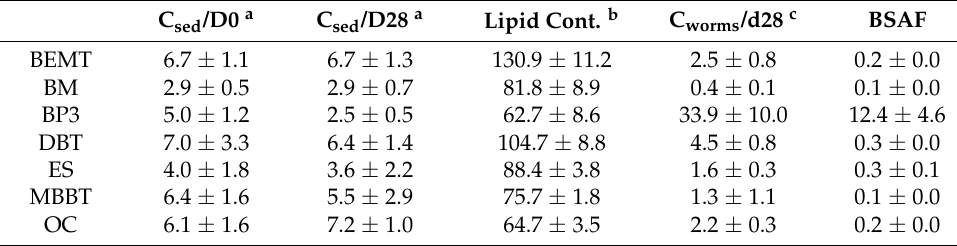
Table 2. Concentration of UV filters found in sediments at day 0 and day 28 ( µ g · g − 1 dry weight), lipid content in worms at day 28 ( µ g dry weight), concentrations of UV filters in Hediste diversicolor at the end of the 28-day exposure ( µ g · g − 1 dry weight), and Biota-Sediment Accumulation Factor (BSAF) calculated for each UV filter. The percentage of total organic carbon (% TOC) used for calculation of BSAF was 5%.